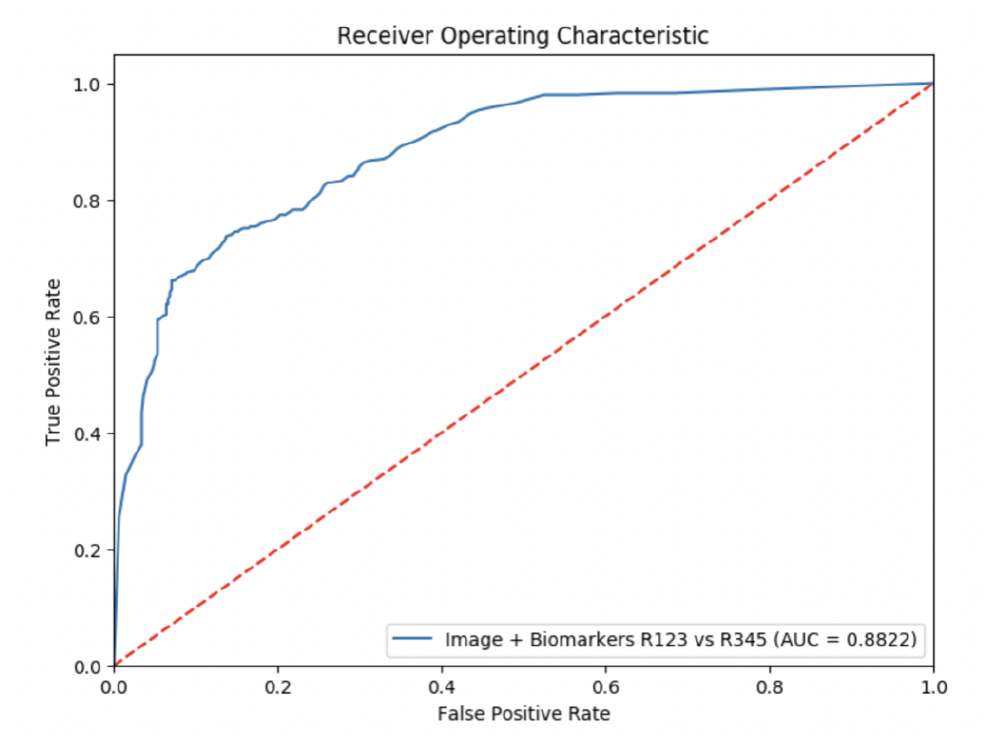
Figure 10. ROC curve using LIDC 3D images and image characteristics as input. The red dotted diagonal represents ROC curve for a random